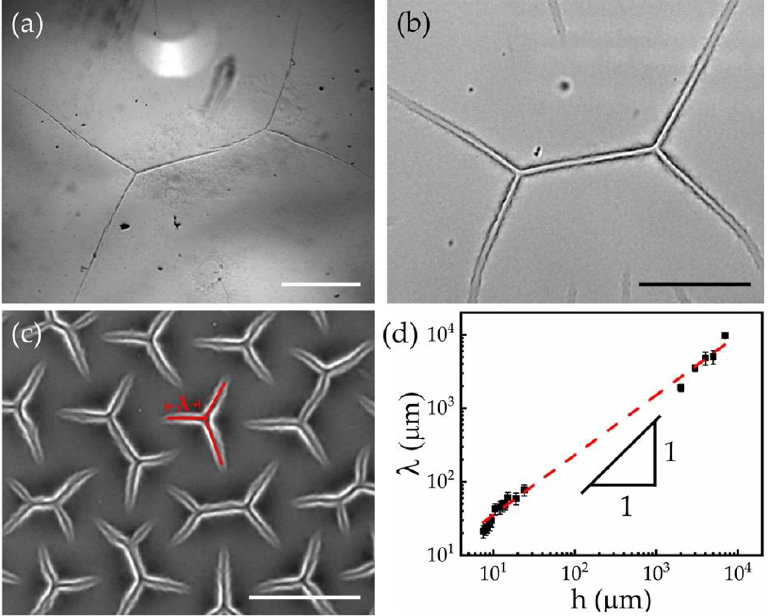
Figure 2. Instability features on samples with different thicknesses. Brightfield microscope images of the instability patterns generated on samples with the thicknesses of 1 mm ( a ), 24 µm ( b ), and 7.5 µm ( c ), respectively. The scale bars are 1 mm in ( a ) and 50 µm in ( b , c ). ( d ) Characteristic feature length ( 𝜆 ) is plotted against the sample thickness ( ℎ ). The red dashed line indicates the best power-law fit to the experimental results, 𝜆 = 5.4 ℎ 0.8 .